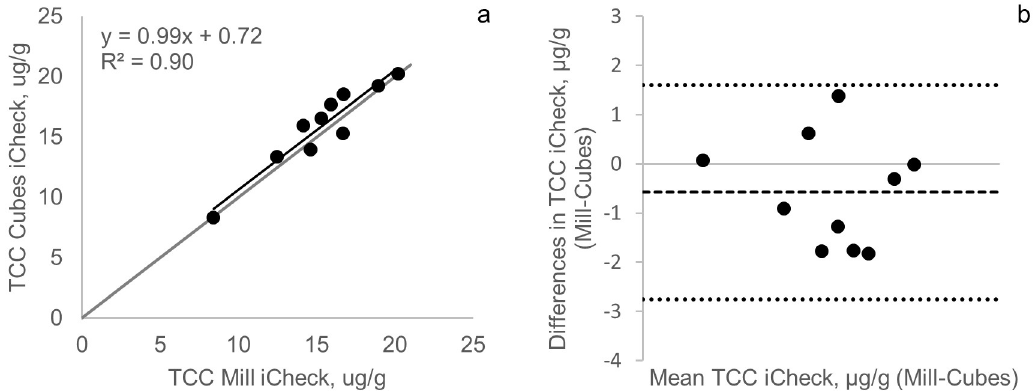
Fig 5. Scatterplot and Bland Altman comparison between total carotenoid concentration (TCC) in cubes and milled samples for iCheck Carotene. The black line indicates the linear regression line. The gray line indicates the line of identity. The square dotted line represents the bias and the round dotted lines represents the 95% confidence interval.